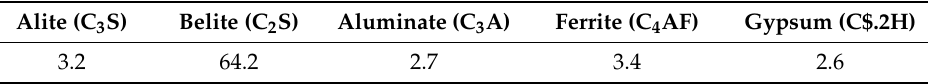
Table 2. Mass percentage of crystalline phases determined by QXRD for the cement.